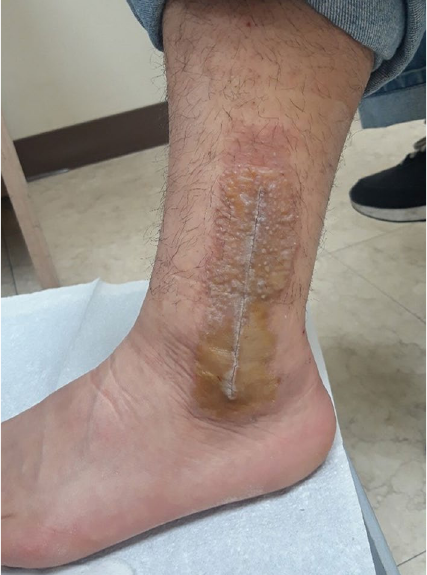
Figure 1. Clinical photograph of a patient showing well-demarcated pruritic eczematous eruption, papules, and vesicles that developed in the skin area to which topical skin adhesive was